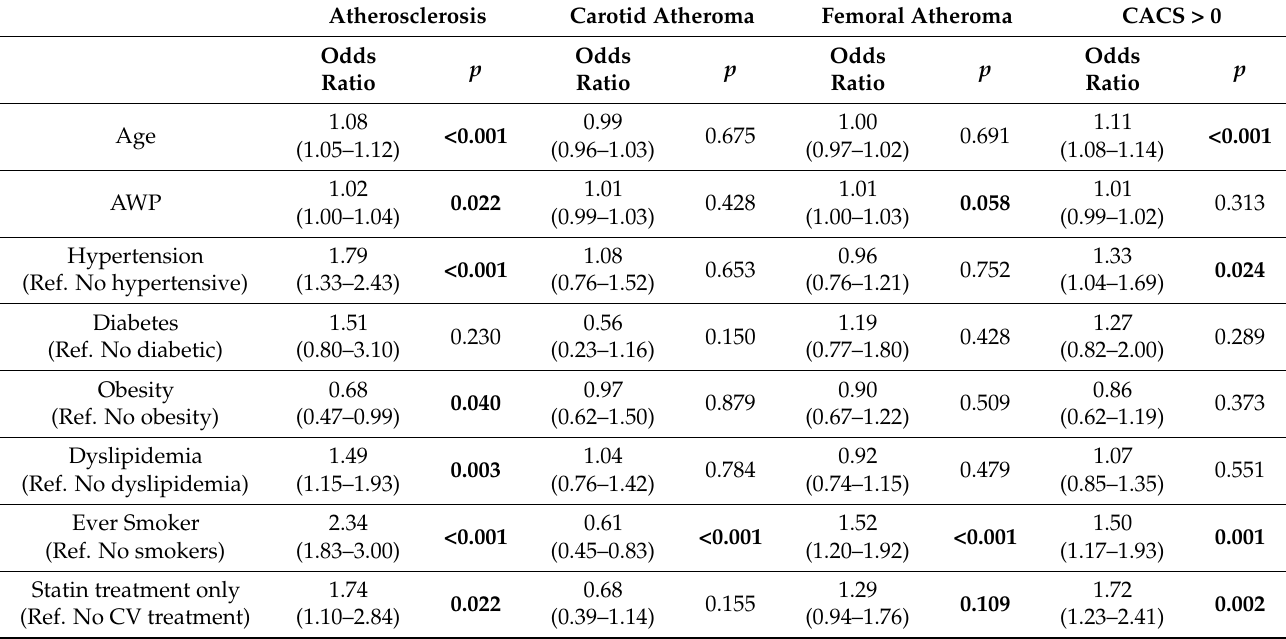
Table 6. Association between statin treatment only and the presence of subclinical atherosclerosis, adjusted by cardiovascular risk